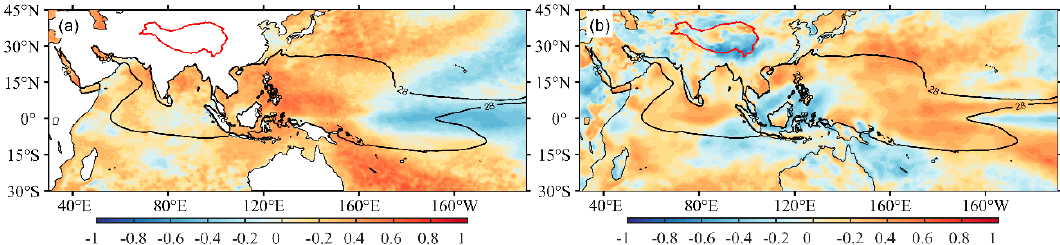
Figure 10. ( a )The linear regression pattern of summer WVB over the TP and the SST of the IPWP, ( b ) is the same as ( a ), but for the slhf. Table 2. The correlation coefficients of the WVB of 13 basins within the TP and climate indices of the IPWP. Climate Indices Basins